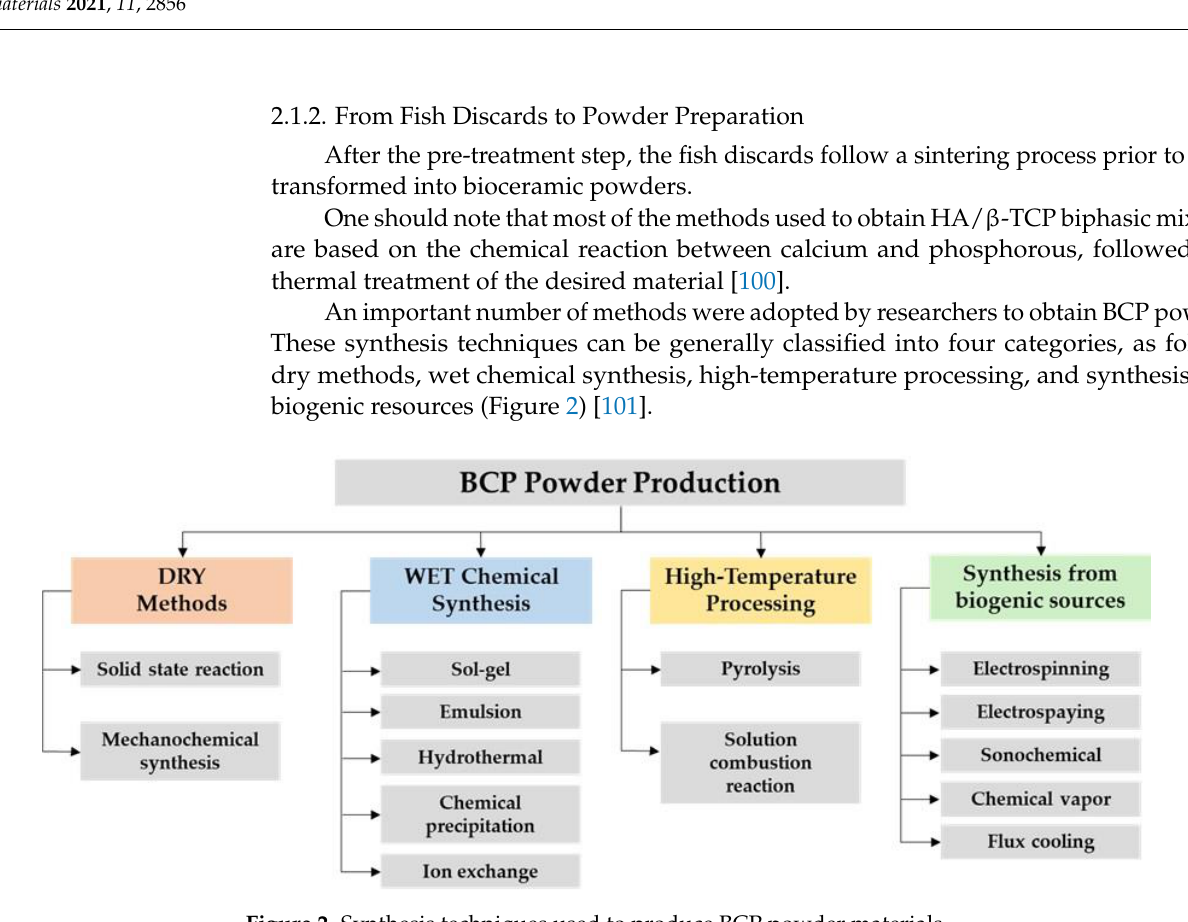
Figure 2. Synthesis techniques used to produce BCP powder